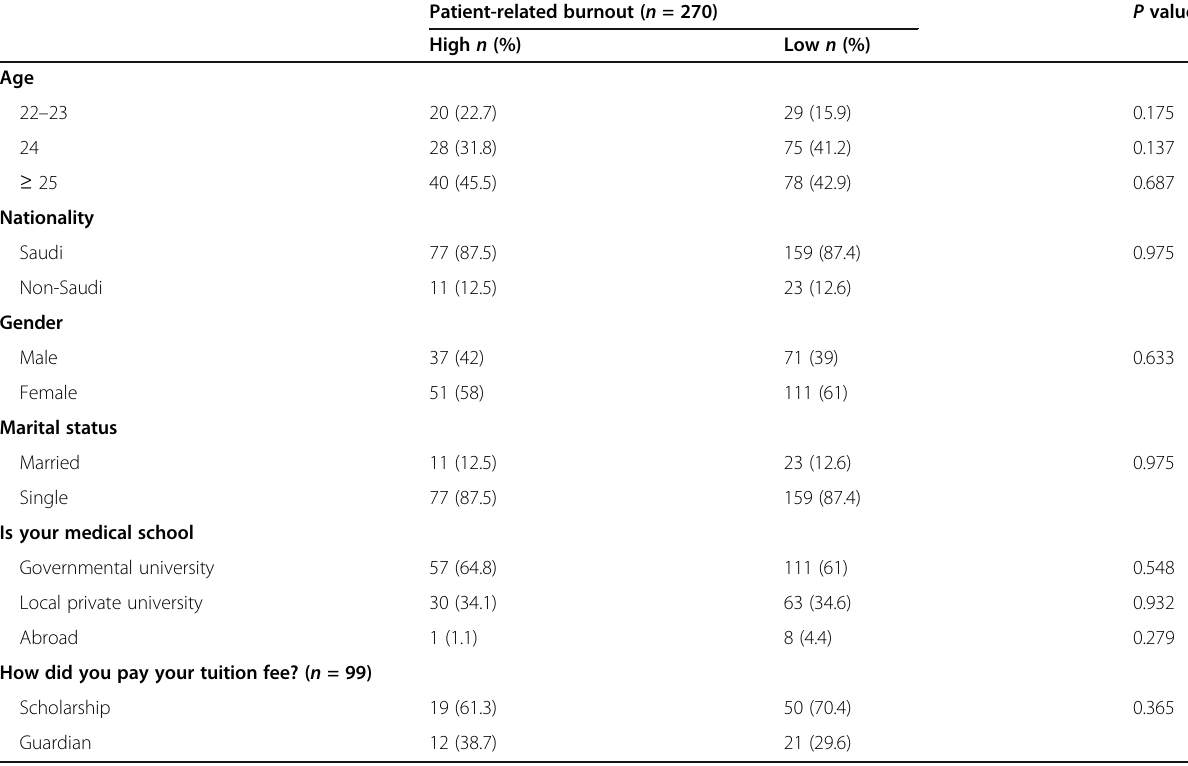
Table 6 Factors related to patient-related burnout